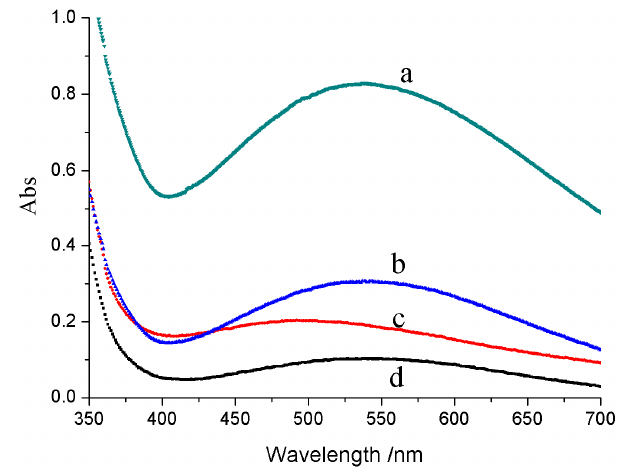
Figure 4. UV-Vis spectra of SQA-iron(II/III) system catalyzed by Au/MWCNTs ( a ); MWCNTs ( b ); Au NPs ( c ); H 2 O for blank control ( d ).